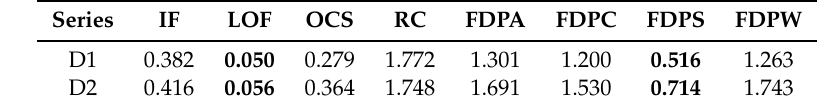
Table 4. Average time cost (in seconds) of dataset series, data sizes ranged from 1000 to 10,000. The best time cost of the FDP algorithms and the best time cost of the comparison algorithms are respectively marked in bold font.